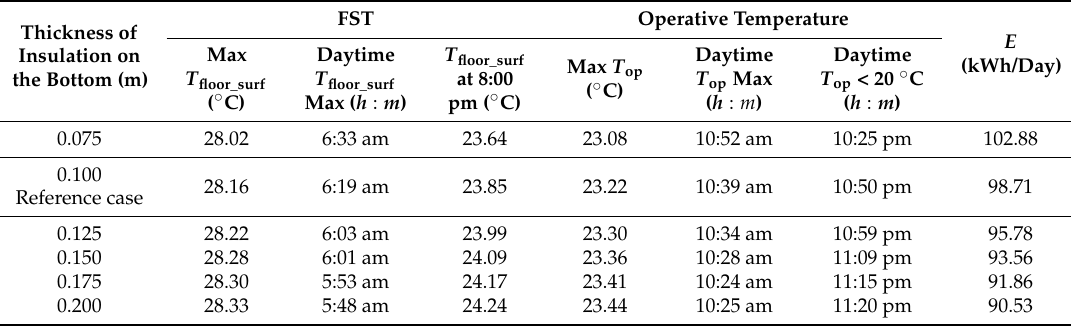
Table 4. Results of the parametric study: Impact of the lower layer Insulation thickness. Thickness of Insulation on the Bottom (m)